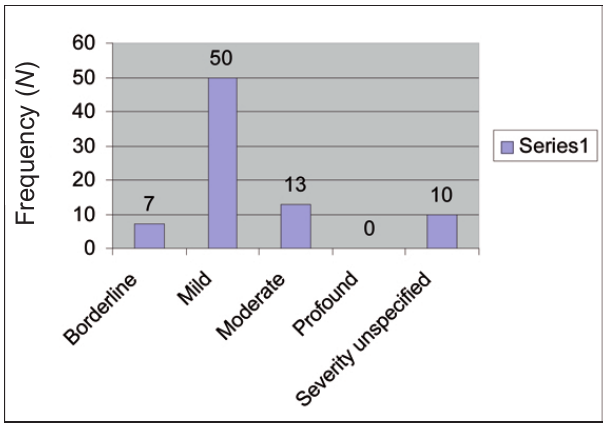
Fig. 2. Level of intellectual